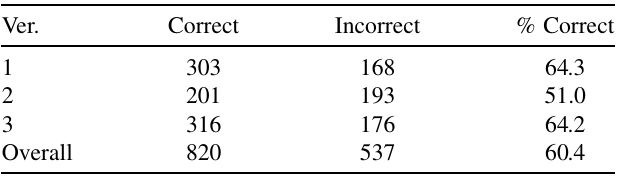
TABLE I. As part of a final proctored lab assignment, students completed a partially constructed program which modeled the motion of an object under the influence of a central force. The partially written program defined the objects, some constants, and the numerical integration loop structure. The initial conditions, the sign ( (cid:3) ) and distance dependence ( r n ) of the force, and object names were randomized on a per-student basis. Slightly modified versions (Ver.) of this assignment were given at the end of three different semesters. Modifications were made to streamline delivery (version 1 to version 2), minimize transcription errors, and improve presentation (version 2 to version 3). Students’ performance on version 1 was likely inflated because some students were allowed to work the problem on two separate